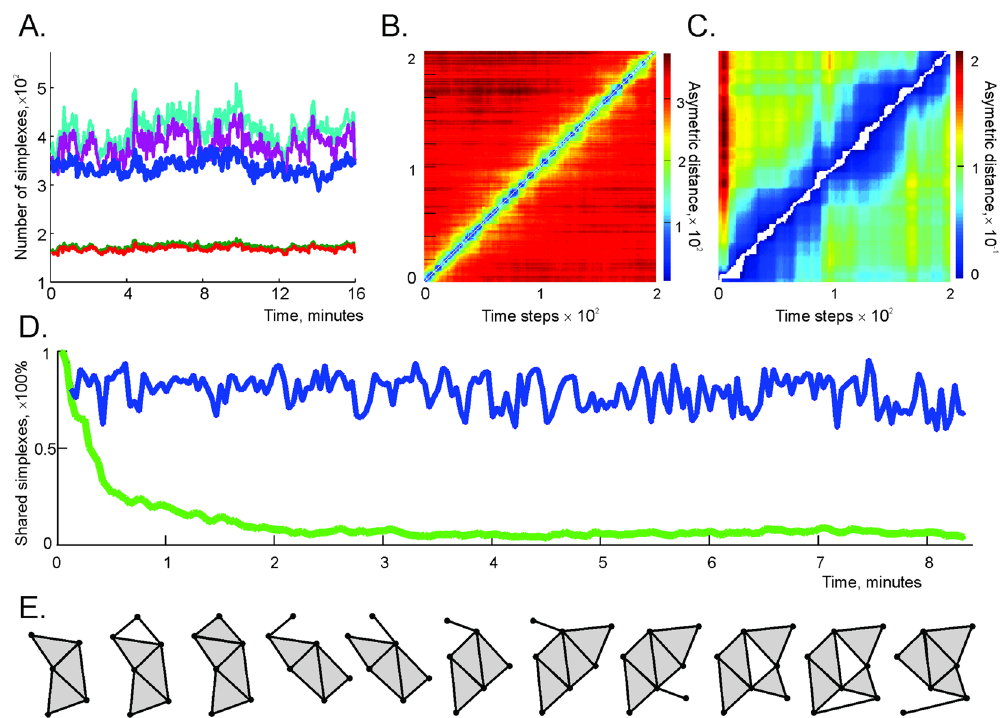
Figure 4. Behavior of the flickering coactivity complex computed for the memory window width ϖ = 4 min, shifted over Δ t = 2.5 secs steps, i.e., at the discrete times t k = k Δ t . ( A ) The number of maximal simplexes in ϖ   (red (blue trace) fluctuates within 4% of the mean value of N ς = 320. The number of the 1 D simplexes ϖ N ( ) 1  and trace) and the number of the 1 D simplexes appearing in consecutive windows (i.e., links shared by ϖ t ( ) i ϖ − t ( ) i 1  , green trace) fluctuate within a 3% bound. The fluctuations in the number of 2 D subsimplexes ( ϖ N ( ) 2  , light blue trace) and the number of 2 D simplexes shared by two consecutive windows (purple trace) do not  and  ϖ N ( ) exceed 7% of the mean. ϖ N ( ) are scaled down by a factor of 10 to fit the scale of the figure. ( B ) The 1 2  and asymmetric distance d ij between ϖ t ( ) ϖ t ( ) j  is defined as the number of the maximal simplexes at moment i t i that are missing at the moment t j . As the timestep separation | i − j | grows, d ij rapidly increases. ( C ) The matrix of similarity coefficients r ij between the weighted coactivity graphs at different timesteps. For close timesteps i and j , the differences between the corresponding coactivity graphs G ( t i ) and G ( t j ) are small, but as time separation grows, the differences accumulate, though not as rapidly as with the coactivity complexes. ( D ) At each moment, t i , the blue line shows the proportion of maximal simplexes present at the previous time, t i − 1 . The  ) that remain in the green line shows the proportion of maximal simplexes contained at the start (in ϖ t ( ) 1 coactivity complex at the later time  ϖ t ( ) . The population of simplexes changes by about 95% in about 2 min. i ( E ) A schematic illustration of the changes of the coactivity complex’s shape: rather than exhibiting